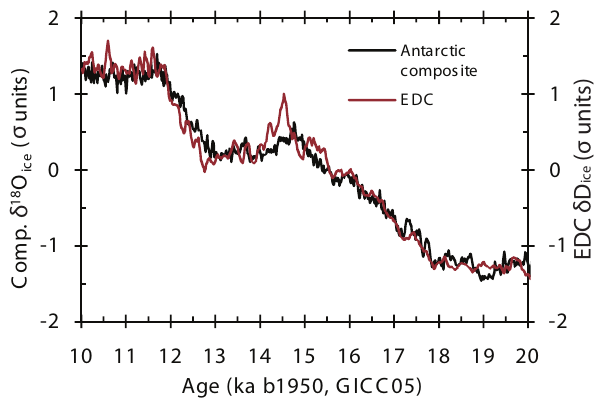
Fig. 4. A comparison of the Antarctic composite with the EPICA Dome C (EDC) δ D ice record. The GICC05 consistent timescale for EDC is from Lemieux-Dudon et al. (2010) and δ D ice data are from Jouzel et al.